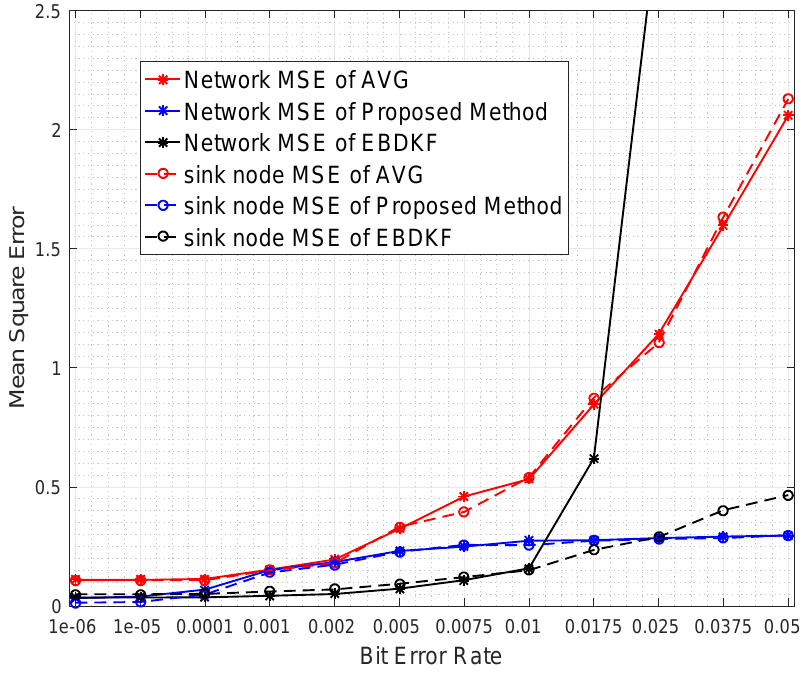
Figure 4. Performance comparison among the proposed statistical, EBDKF, and AVG information fusion methods in a chain-based IoT platform for different